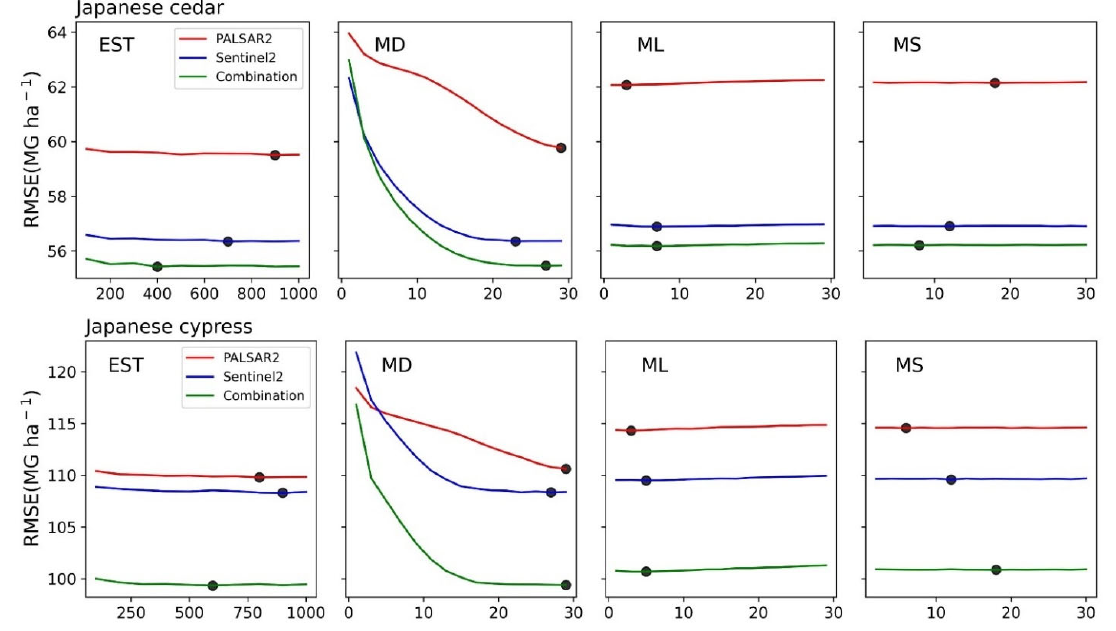
Figure 5. Results of tuning the hyperparameters in the three models: EST, the number of trees in the forest; MD, the maximum decision-tree depth; MS, the minimum number of samples required to split in every internal node; ML, the minimum number of samples required at every leaf node. The value with the minimum root-mean-square error is shown with a black circle.